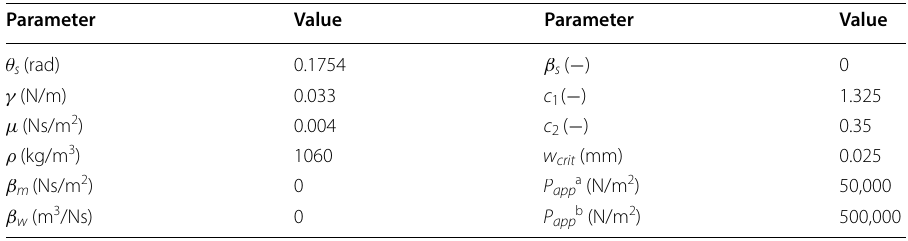
Table 4 Flow model